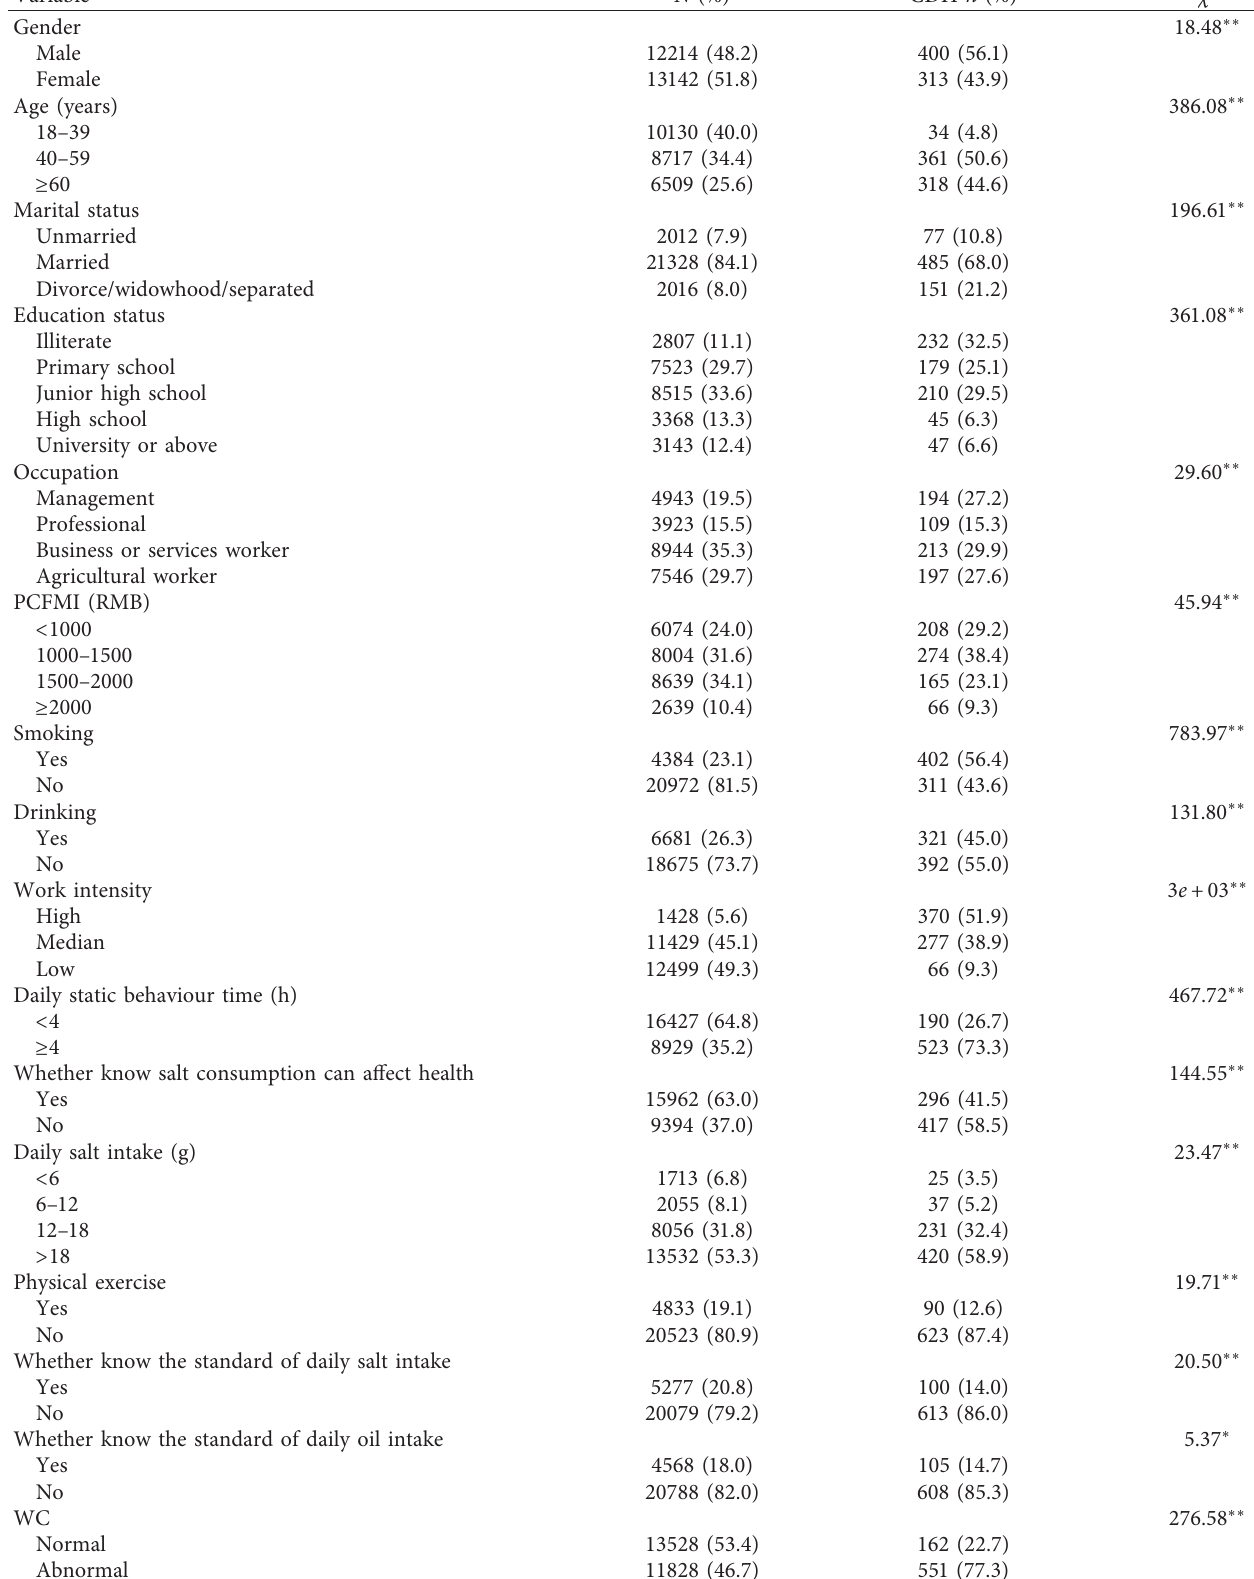
Table 1: General characteristics of the survey participants and